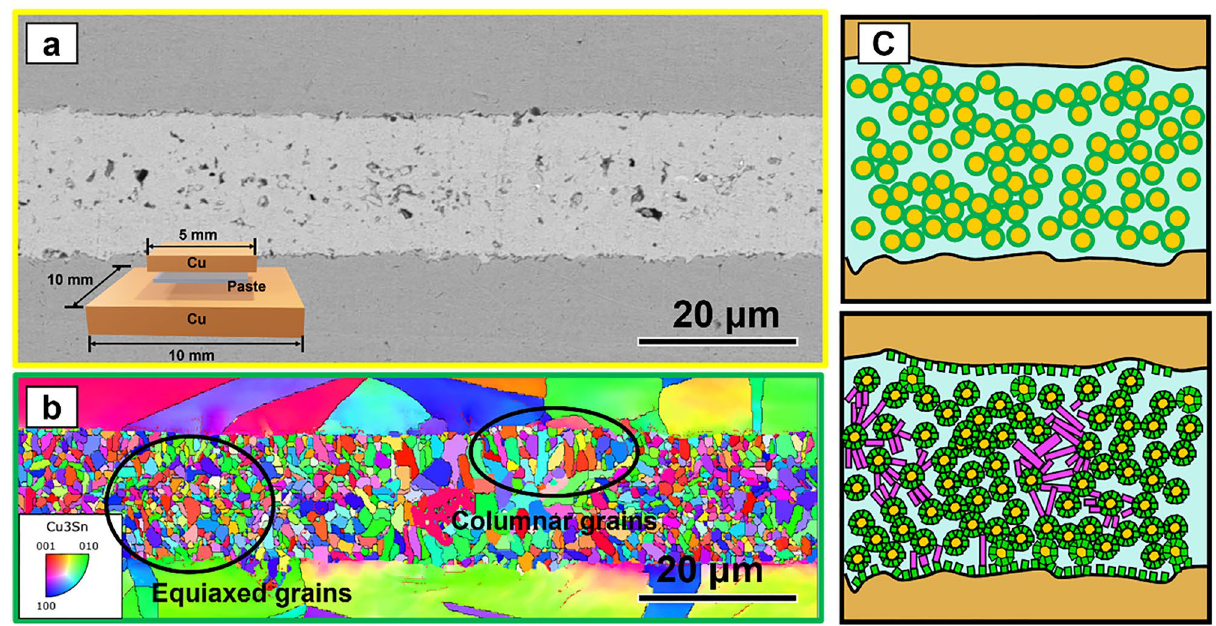
Figure 6. EBSD mapping of the joint (10 MPa auxiliary pressure, 60 min reflow at 280 ℃ ) ( a ) SEM image of joint reflowed 60 min at 280 ℃ , ( b ) EBSD mapping, ( c ) schematic diagram of the growth of Cu 3